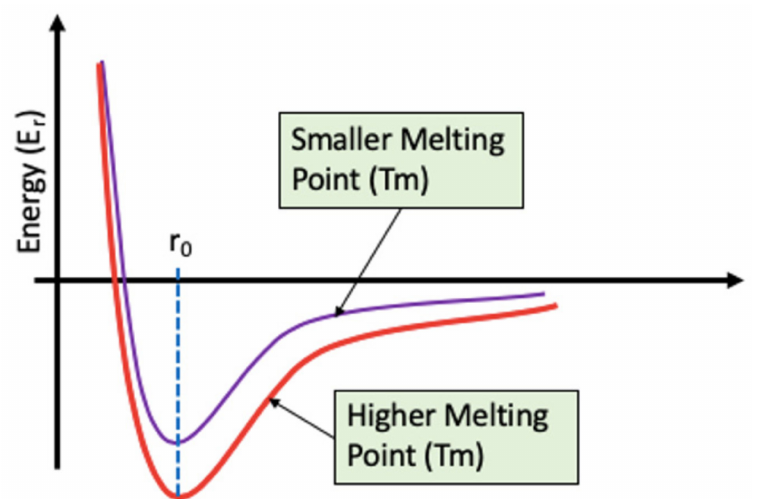
Figure 7. Typical potential energy curve showing the shape of the well with increase in melting point